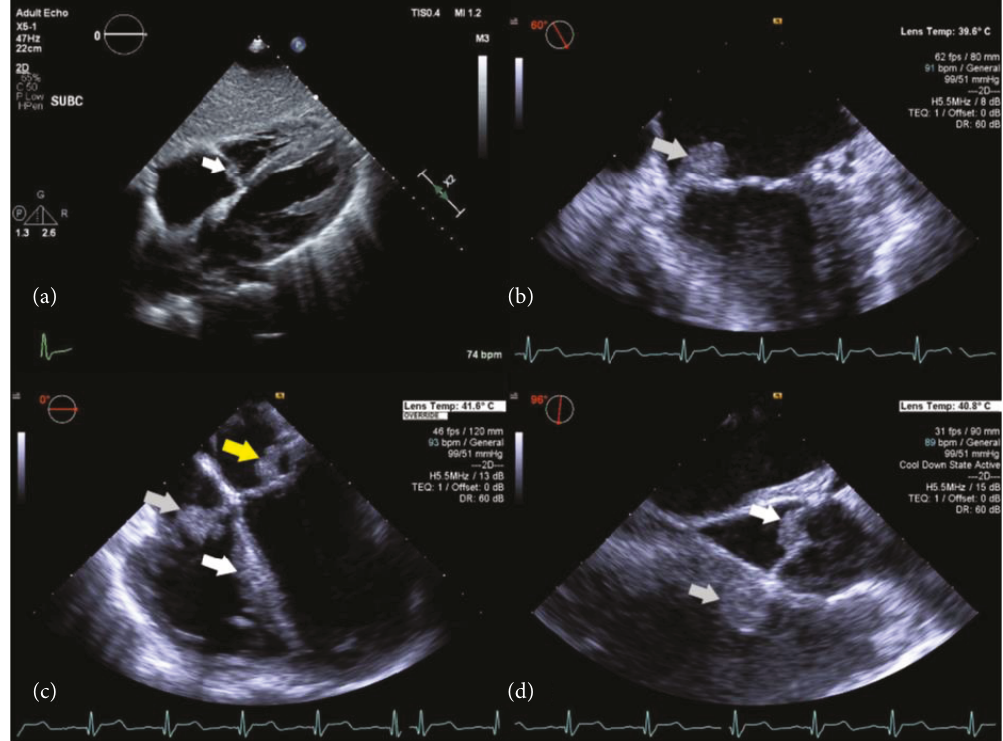
Figure 1: (a) Tricuspid valve vegetation on TTE (white arrow). (b) Mitral valve vegetation on TEE (grey arrow). (c) TEE showing mitral valve vegetation (grey arrow), RV out fl ow tract vegetation (white arrow), and tricuspid valve vegetation (yellow arrow) from left to right. (d) TEE showing RV out fl ow tract vegetation (grey arrow) and aortic valve vegetation (white arrow) from left to